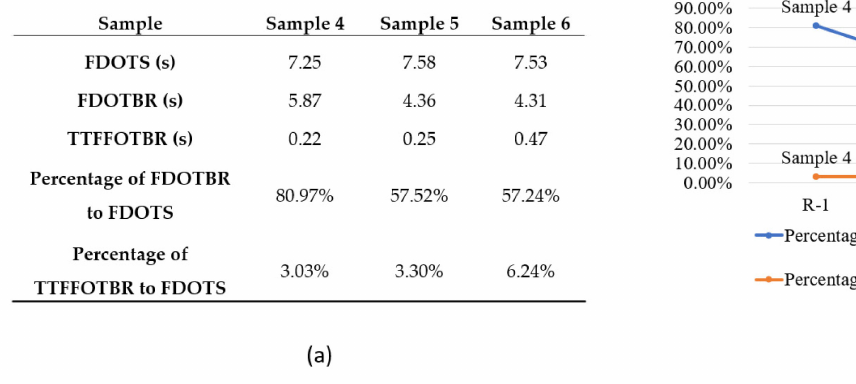
Figure 6. Analysis of fixation time in the experiment 2: ( a ) Data related to fixation time in the experi- ment 2; ( b ) relationship between the percentage of fixation time and the S/L ratio (the experiment